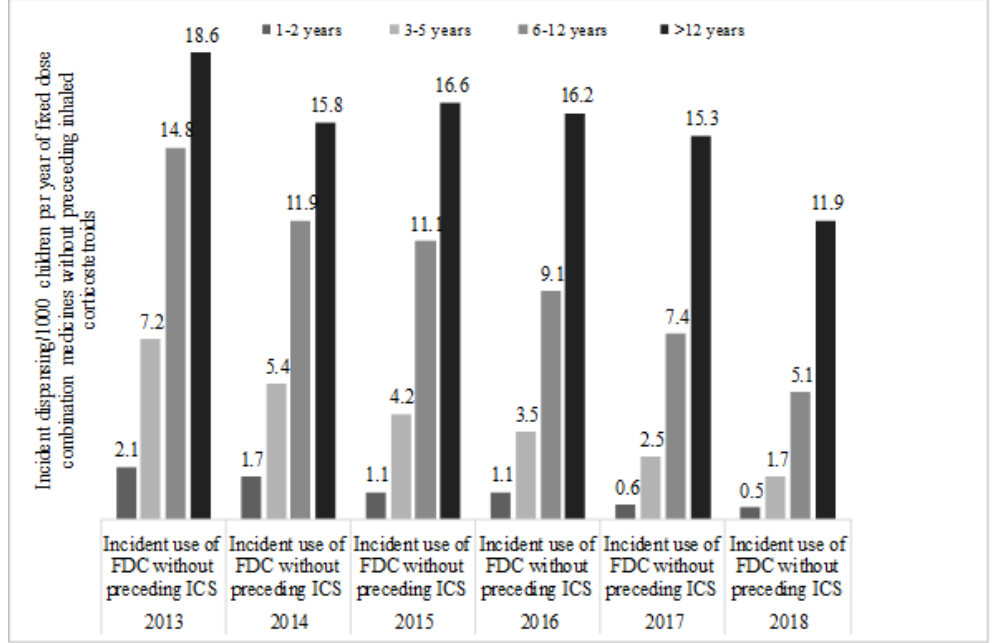
Figure 2. Year and age specific incident dispensing of any fixed dose combination medicine without a preceding dispensing of inhaled corticosteroid in 10% PBS sample of Australian children aged 1–18 years, 2013–2018.